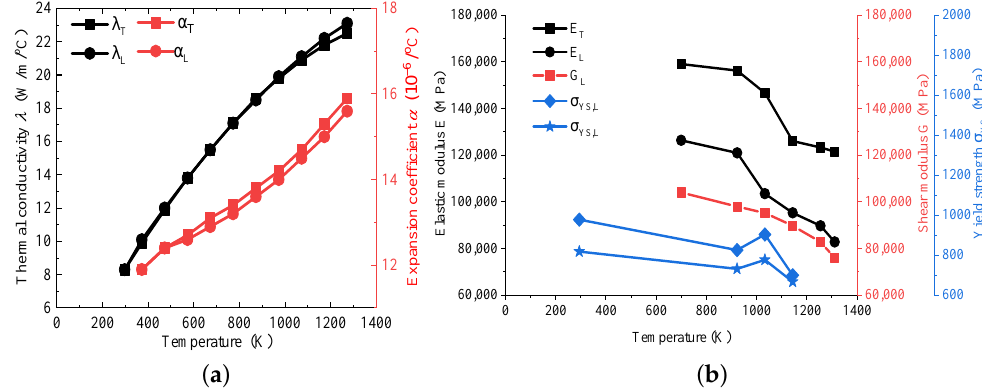
Figure 4. Temperature-dependent material properties of DS GTD-111: ( a ) thermal conductivity and expansion coefficient; ( b ) elastic modulus, shear modulus, and yield strength